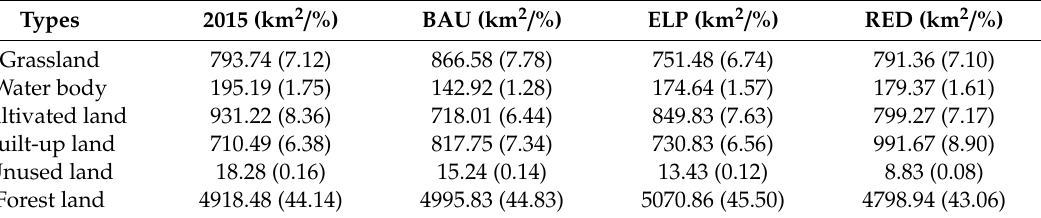
Table 2. Land-use area (km 2 ) and percent area (%) for each land-use type, from baseline year 2015 to